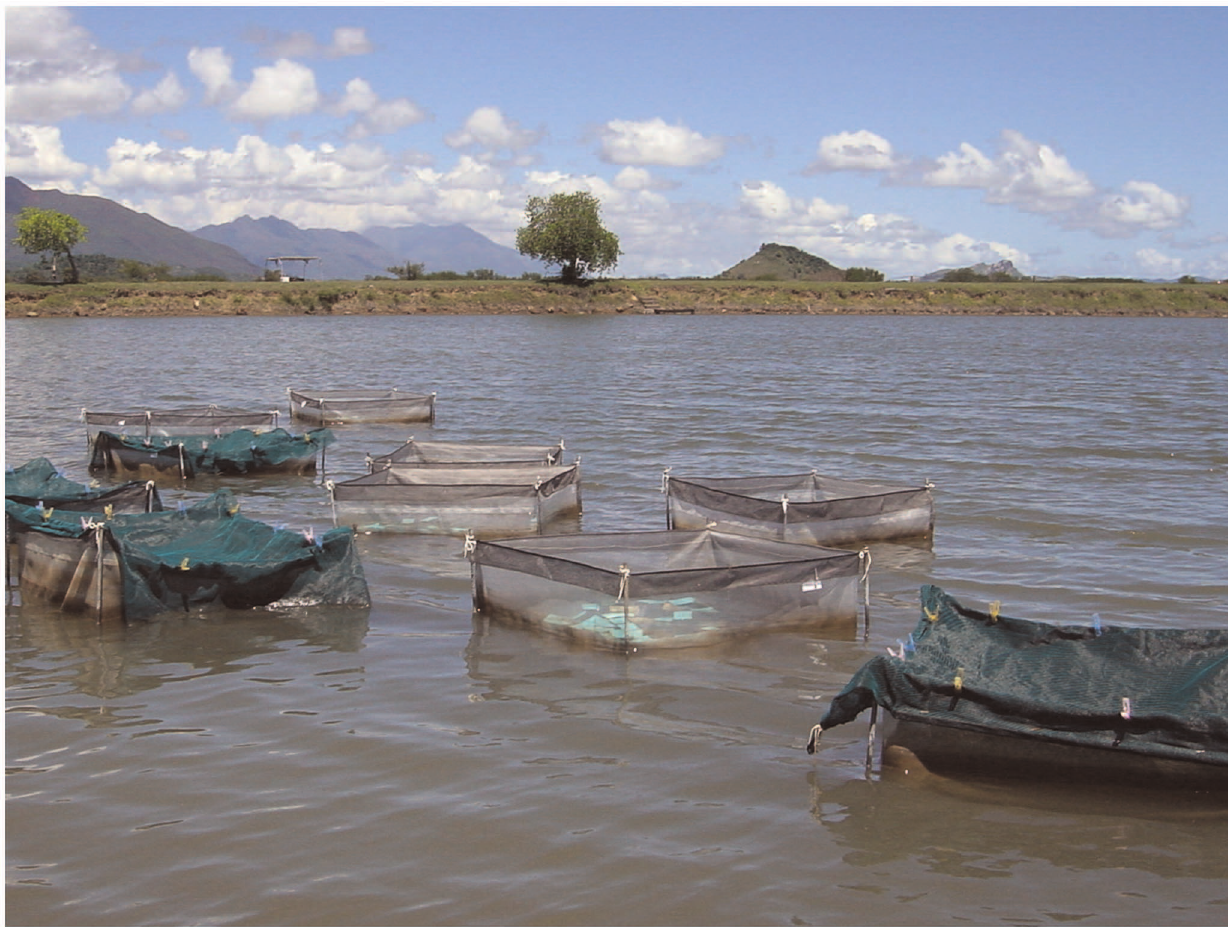
Figure 2. Fine-mesh enclosures. Photograph of 1-m 3 fine-mesh enclosures (660 m m mesh) in the earthen pond during the first experiment (Effects of increasing mesh surfaces and shading), showing some replicates shaded with dark shadecloth and some with stripped shadecloth inside.